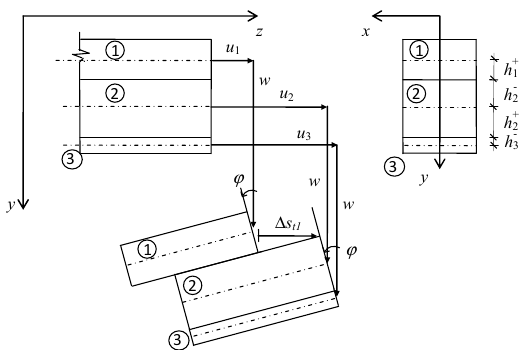
Figure 1. Composite beam assumed in the present model: Geometry and typical deformed configuration.